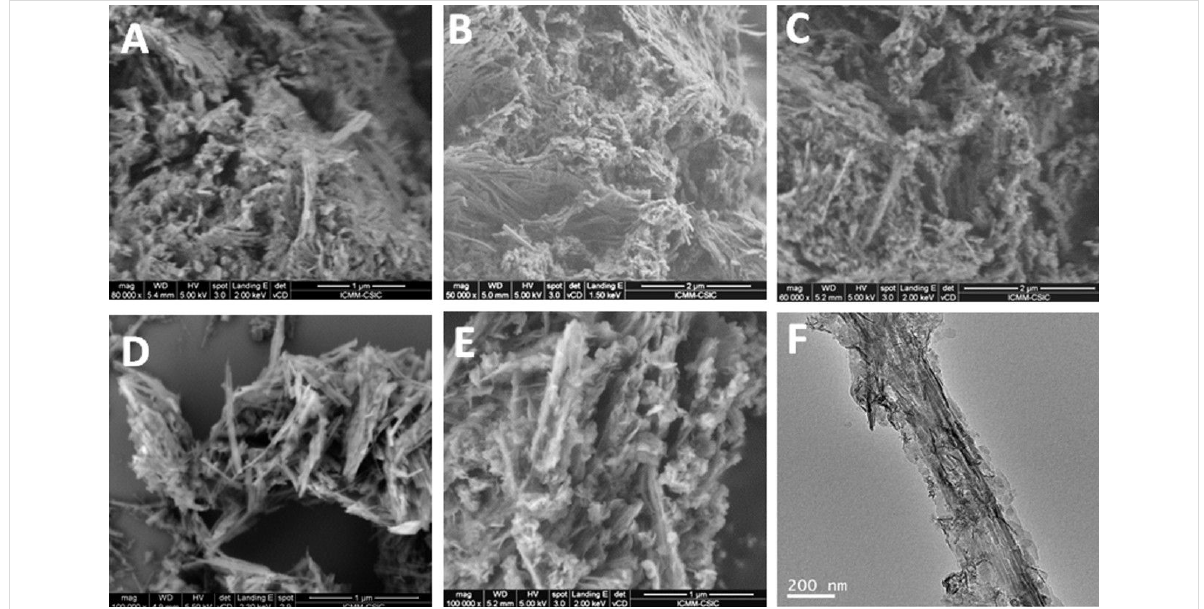
Figure 6: FE-SEM images of (A) MCPA-LDH/Sep2:1_150C, (B) MCPA-LDH/Sep1:1_150C, (C) MCPA-LDH/Sep0.5:1_60C, (D) LDH/Sep0.5:1_150C, and (E) MCPA-LDH/Sep0.5:1_150C hybrid nanoarchitectures prepared by coprecipitation from different LDH/sepiolite ratios; (F) TEM image of the MCPA-LDH/Sep0.5:1_60C hybrid nanoarchitecture.